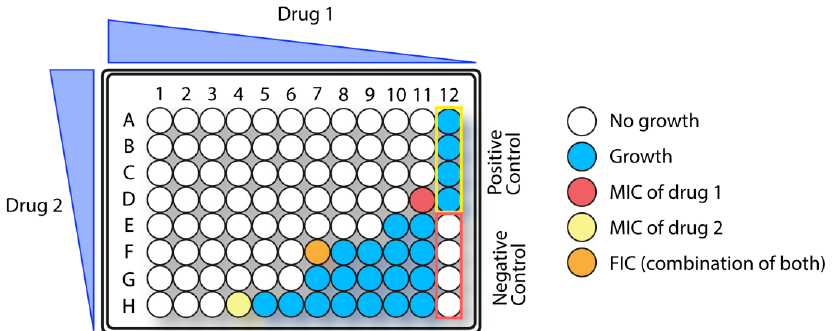
Figure 4. Example of a checkerboard testing of two drugs.